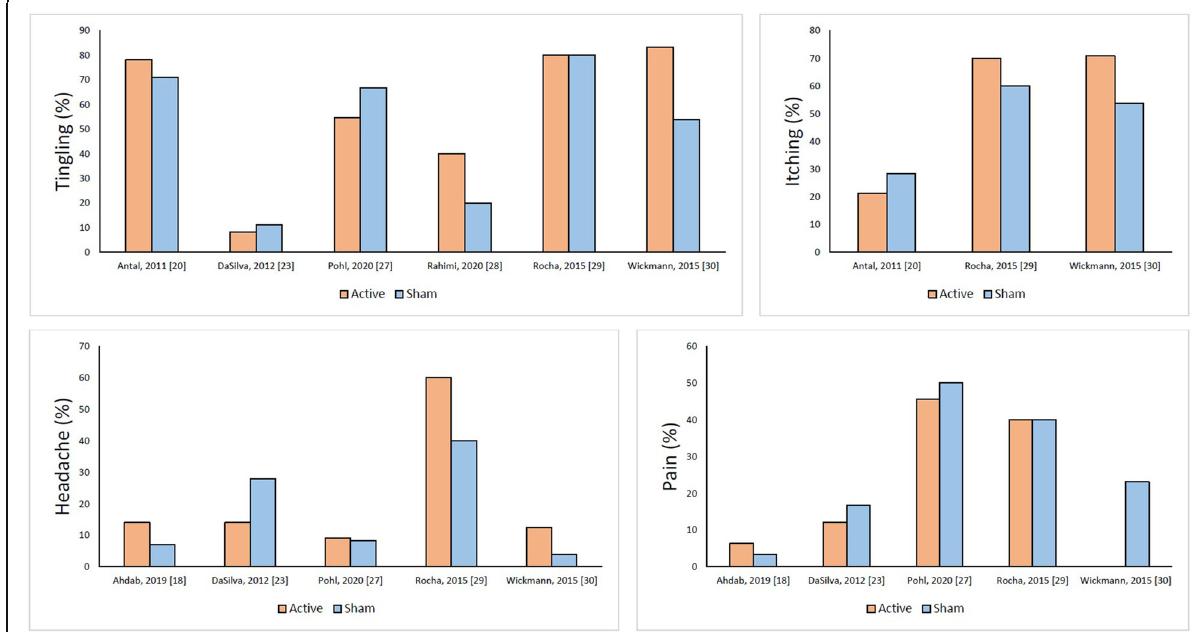
Fig. 6 Proportion of patients with tingling, itching, headache, and pain during tDCS in the included randomized controlled trials. No difference between active and sham groups was